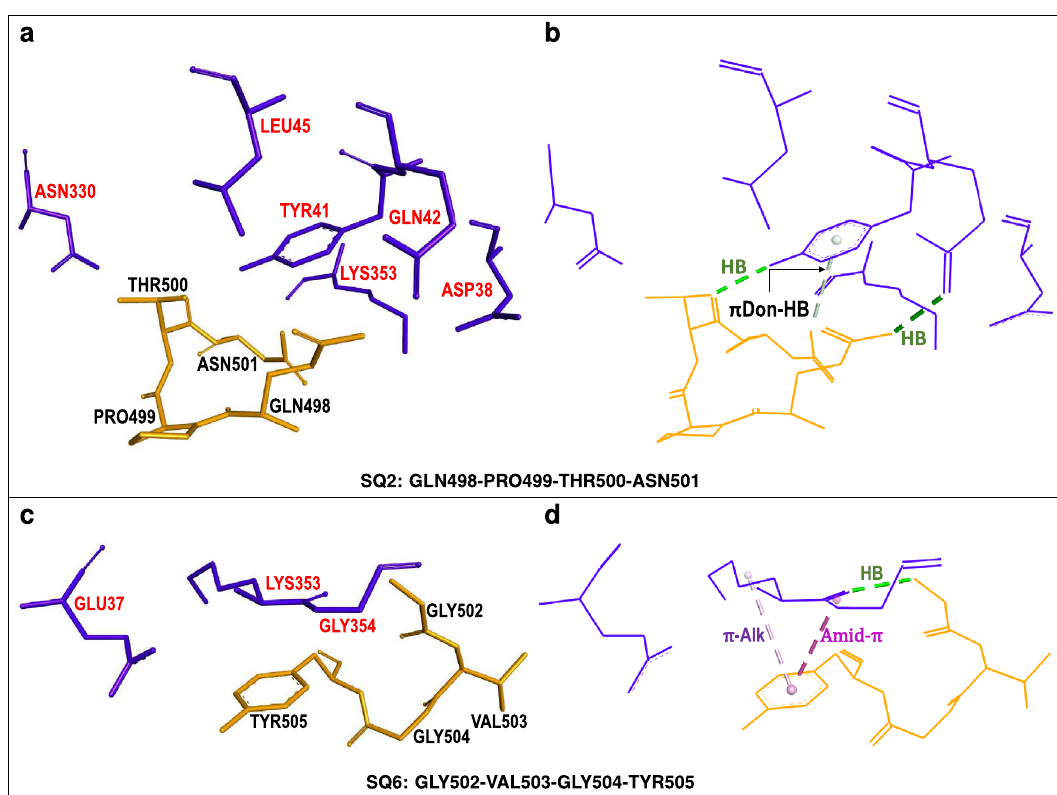
Figure 7. Two S-RBD-centered supermolecular fragments giving rise to attractive hACE2...S-RDB interactions. ( a , c ) SARS-CoV-2 S-RBD quartet residues (shown in brown) and neighboring hACE2 residues (shown in blue) corresponding to weakly attractive host–virus interactions. ( b , d ) Selected intermolecular interactions corresponding to (i) conventional hydrogen bonds (HB) (dotted green lines), (ii) π -donor (non-classical) ( π Don-HB) hydrogen bonds (dotted silver lines) and (iii) π -alkyl ( π -Alk) or amide- π interactions (dotted pink